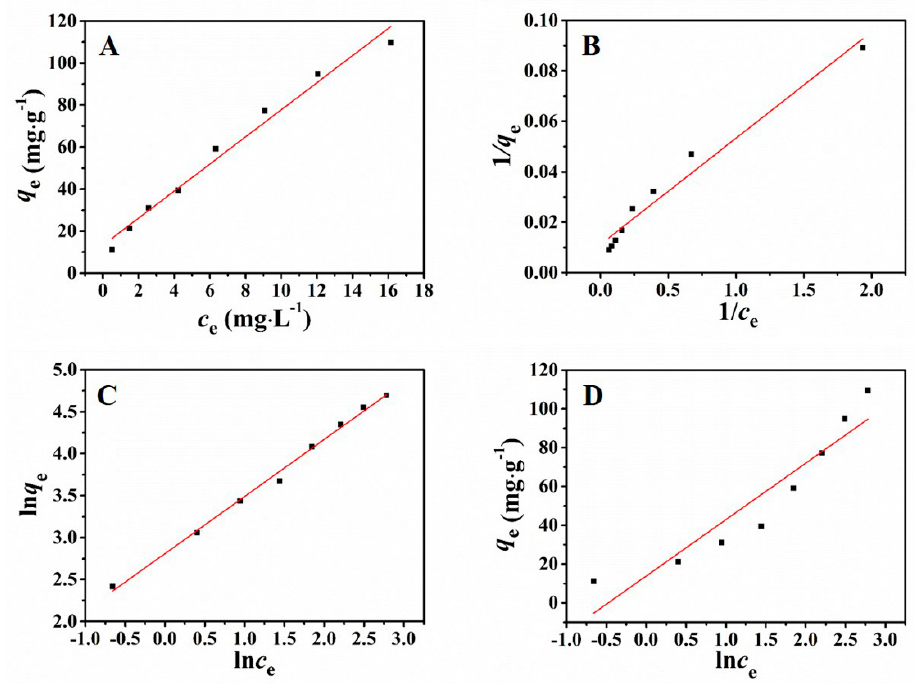
Figure 5. Henry ( A ), Langmuir ( B ), Freundlich ( C ), and Temkin ( D ) adsorption isotherms of Pb 2+ . Table 2. Parameters of adsorption isotherm for adsorbing Pb 2+ with NH 2 –CoFe 2 O 4 /SBA–15.